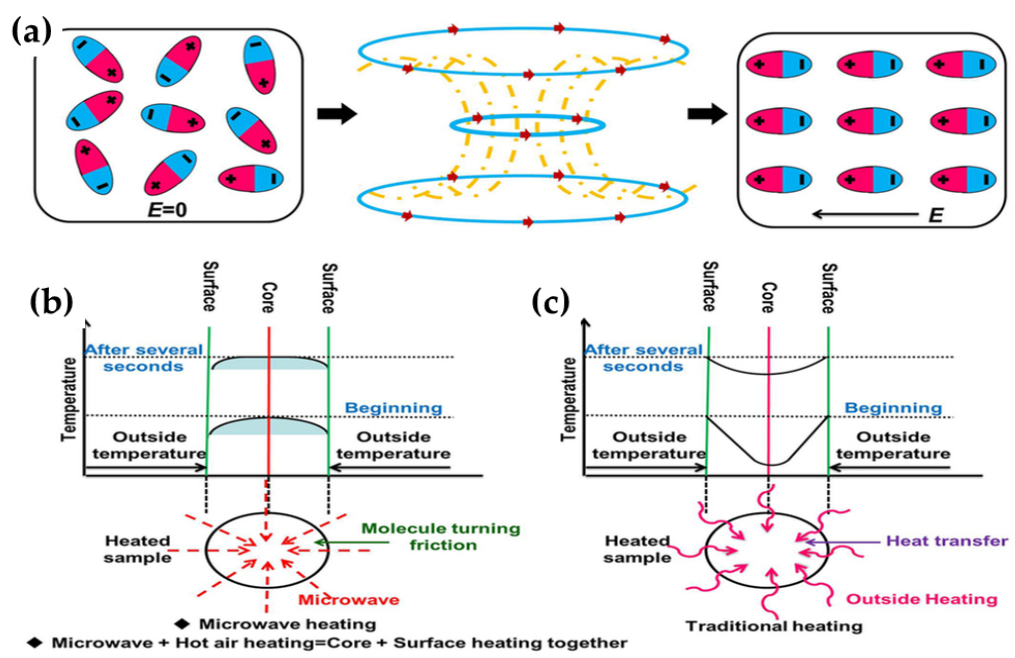
Figure 1. Mechanism of microwave heating ( a , b ), and traditional heating ( c ). Reprinted with permission from the authors of [13]. Copyright © (2015) Nature research.